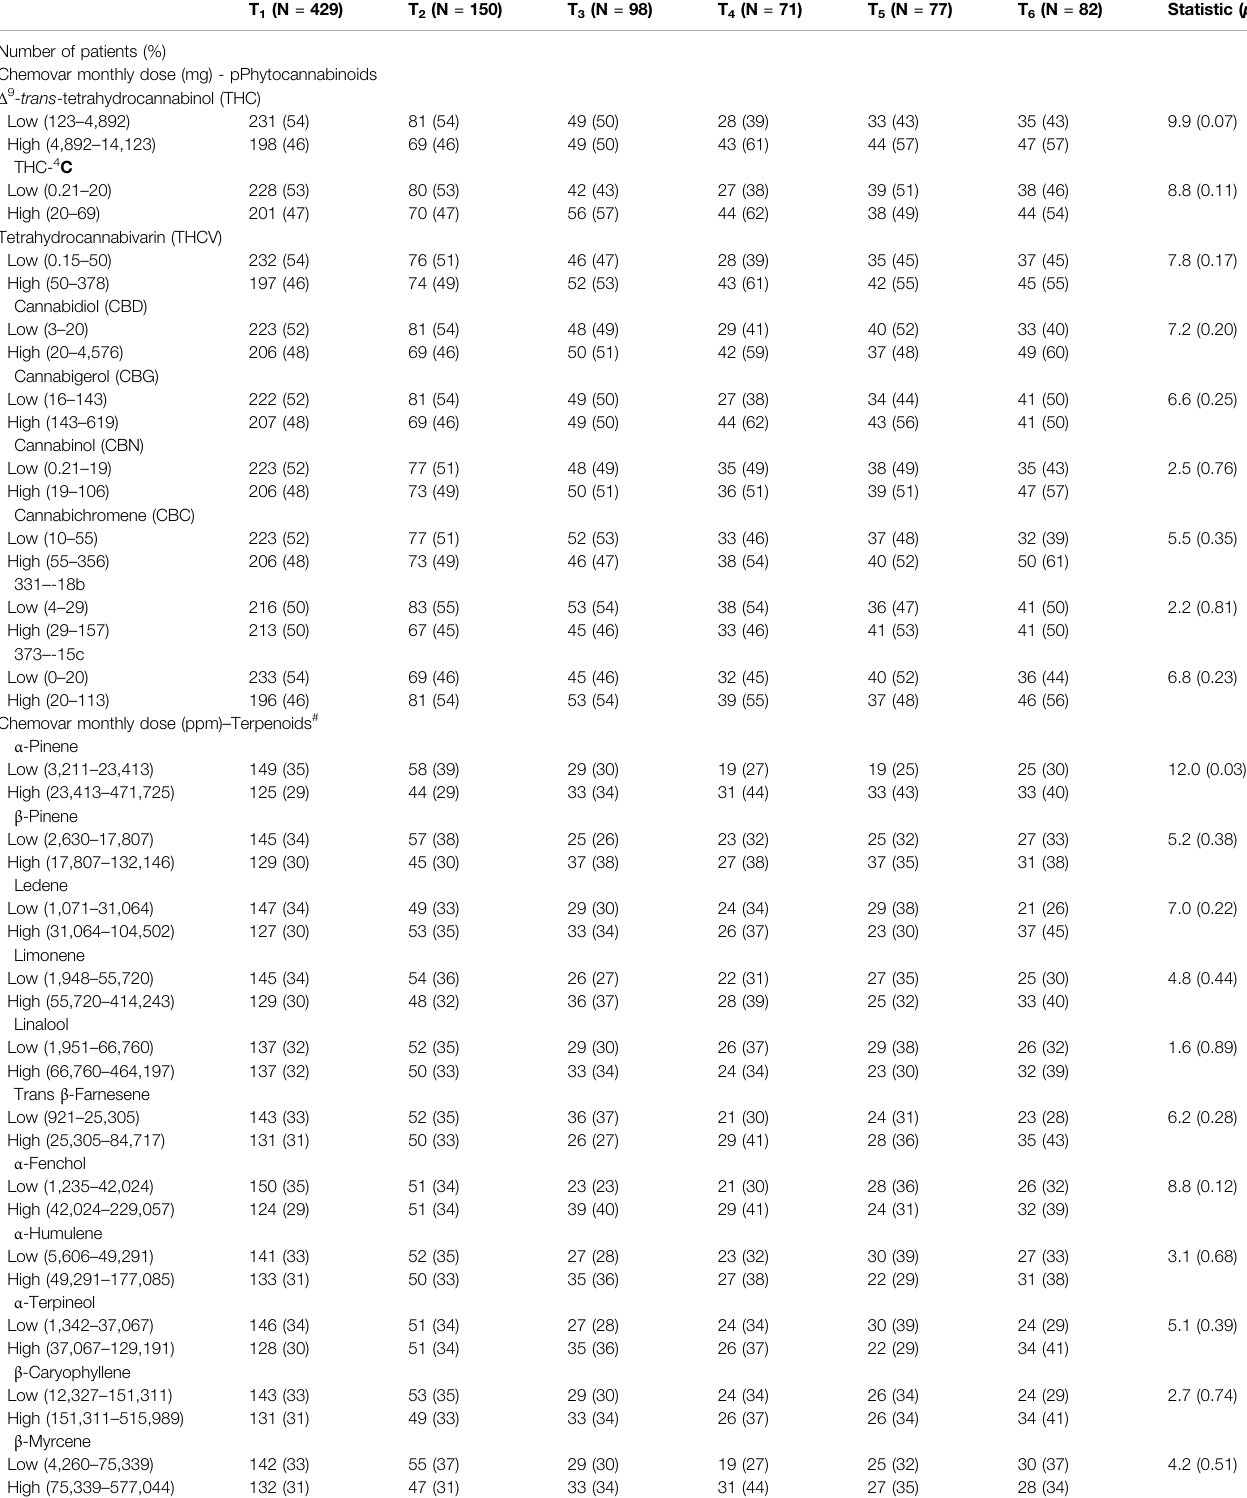
TABLE 5 | Low/high monthly doses rates of the predominant phytocannabinoids and terpenoids consumed by patients of the study sample at one month intervals within a six-month period. T 1 (N = 429) T 2 (N = 150) T 3 (N = 98) T 4 (N = 71) T 5 (N = 77) T 6 (N = 82) Statistic ( p